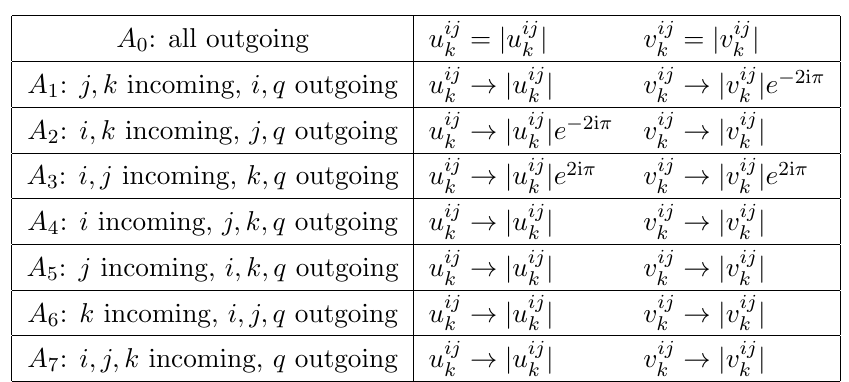
Table 1. Rules for analytically continuing u ij region, to other physical regions. These rules can be obtained from eqs. (2.17) and (3.5). The rules are used below to continue the tripole emission terms to generic physical